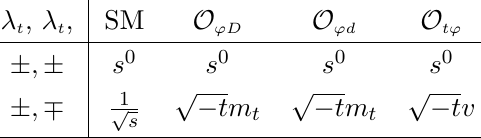
Table 19. Helicity amplitudes in the high-energy limit ( s Overall multiplicative factors are dropped and only the schematic energy dependence is retained for the SM contribution. Helicity entries marked by ‘ section 5.2.4 for a discussion of the